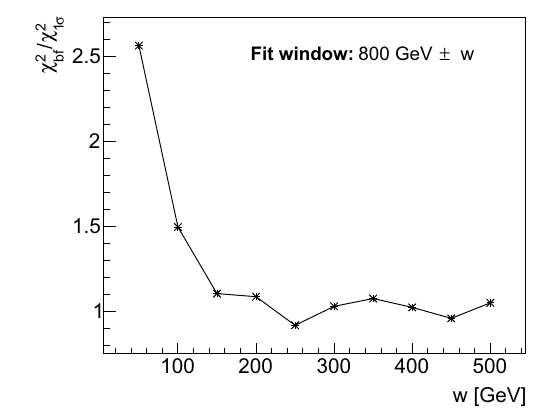
/χ 2 against the width of the fit bf 1 σ